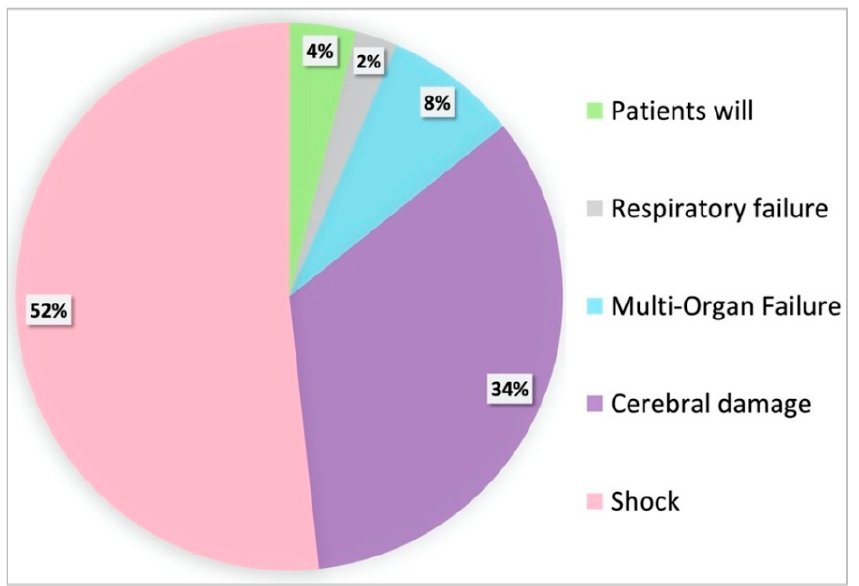
Figure 1. Proportions of the different modes of death given as a percentage of all non-survivors. The most prominent causes of in-hospital death after ECPR were refractory shock followed by cerebral damage.